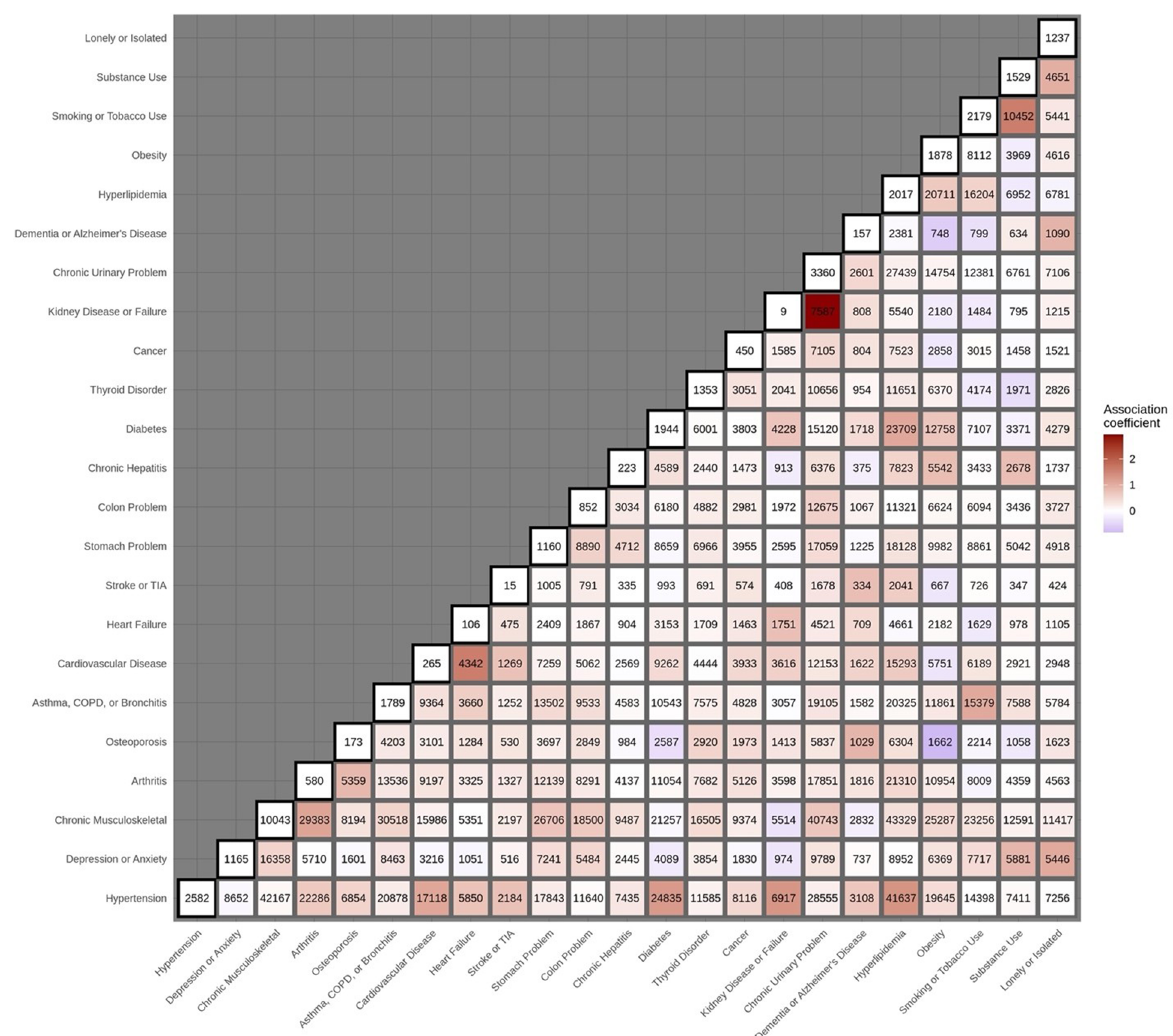
Figure 2: Condition co-occurrence